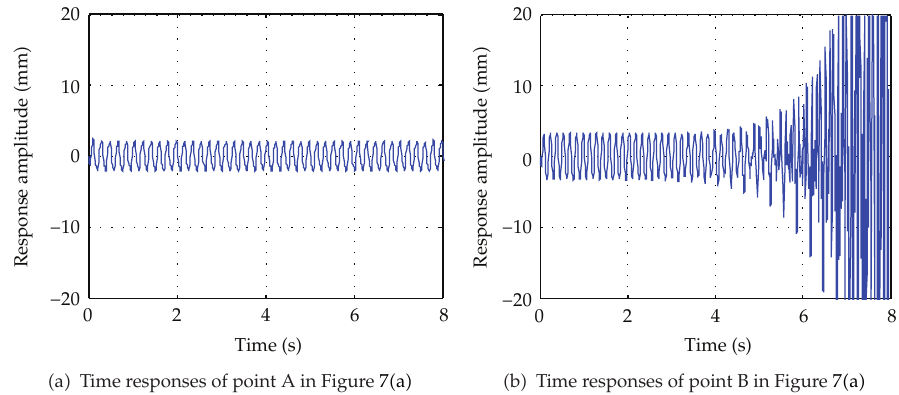
(cid:2) b (cid:3) Time responses of point B in Figure 7 (cid:2) a (cid:3) Figure 8: Time responses of the transverse displacement at electric field E (cid:8)